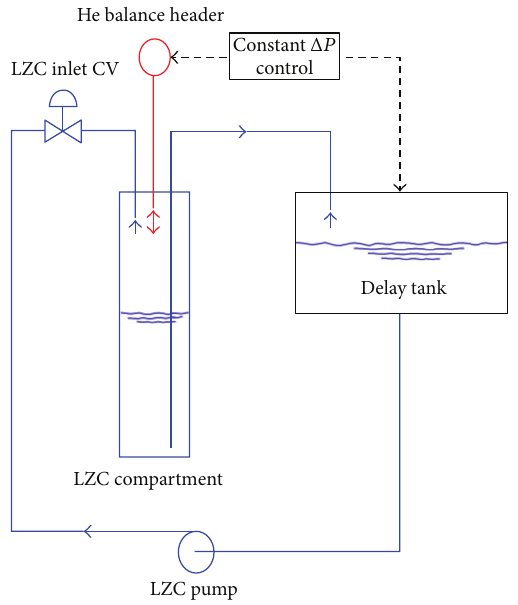
Figure 3: Simplified block diagram of LZ control; only 1 of 14 light- water compartments is